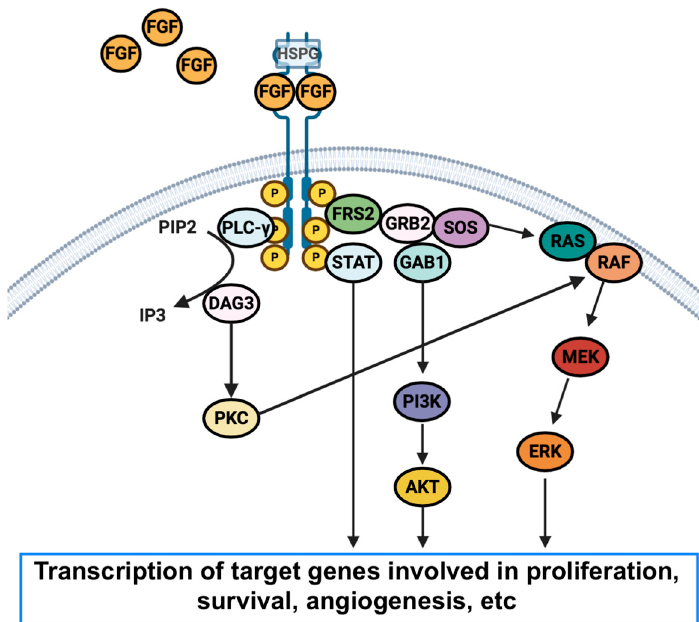
Figure 2. Schematic figure reporting the structure of the Fibroblast Growth Factor Receptor (FGFR), the network, and alteration in tumors. Abbreviations: FRS2: fibroblast growth factor receptor substrate 2; HSPG: heparan sulfate proteoglycan; PLC- γ : phospholipase gamma; PIP2: phosphatidyli- nositol 4,5-bisphosphate; IP3: phosphatidylinositol 3,4,5-triphosphate; DAG: diacylglycerol; PKC: protein kinase C; GRB2: growth factor receptor-bound protein 2; GAB1: GRB2-associated-binding protein; MEK: MAPK/ERK